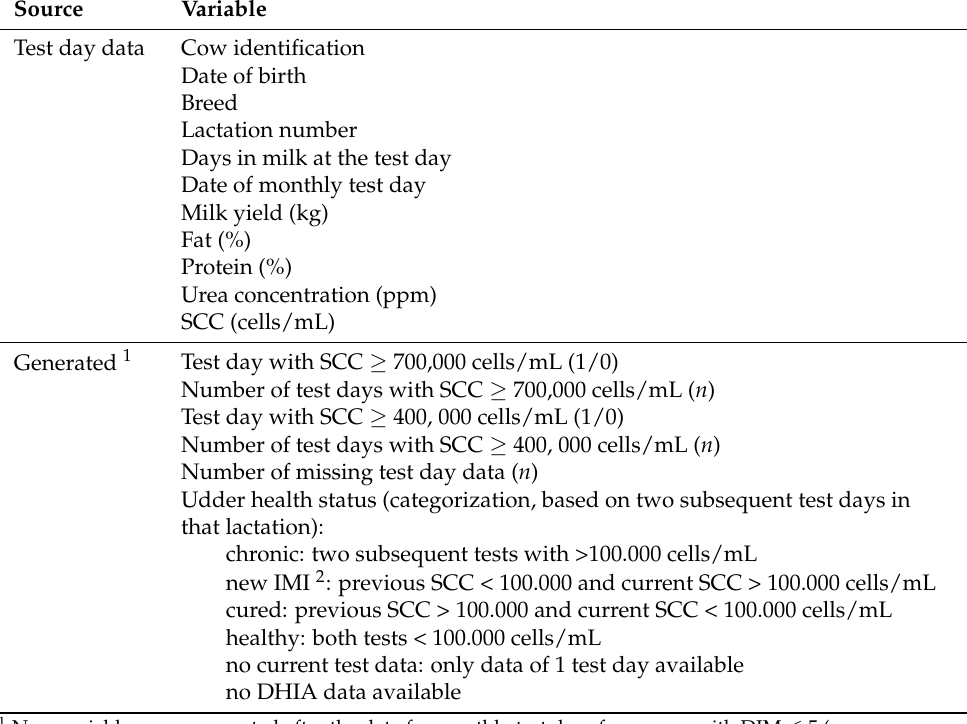
Table 2. Overview of raw and generated cow test day data from the regional Dairy Herd Improvement Association (DHIA) for this study on AMS system accuracy in Bavarian dairy